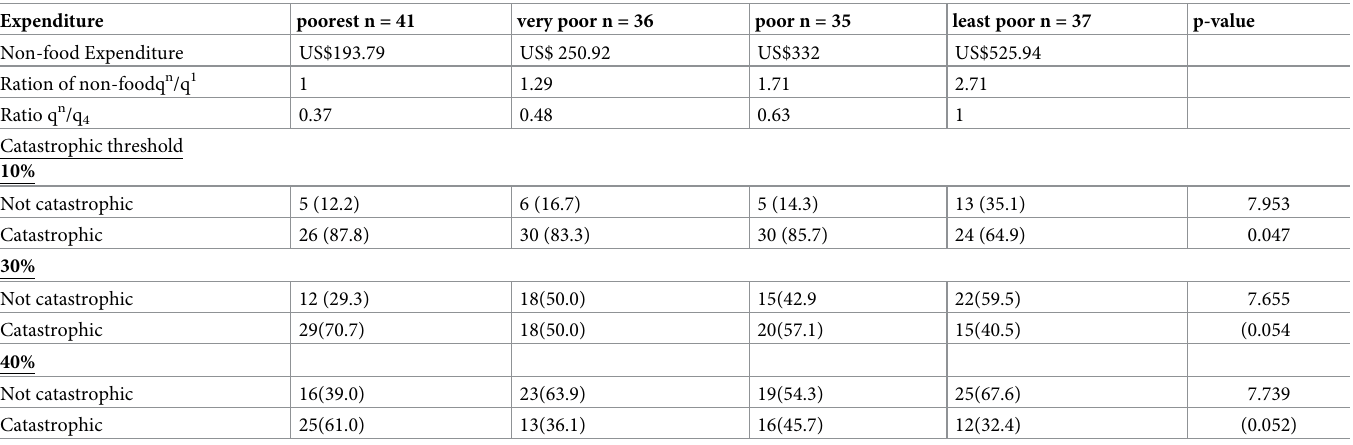
Table 5. Catastrophic expenditure among various socio-economic groups of SCD